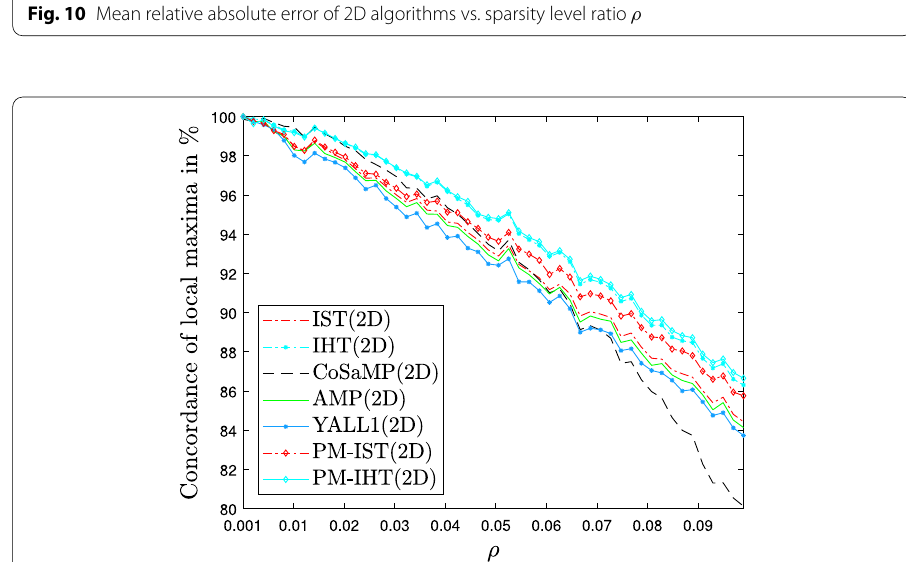
Fig. 11 Concordance of local maxima of recovered RD spectrum vs. sparsity level ratio